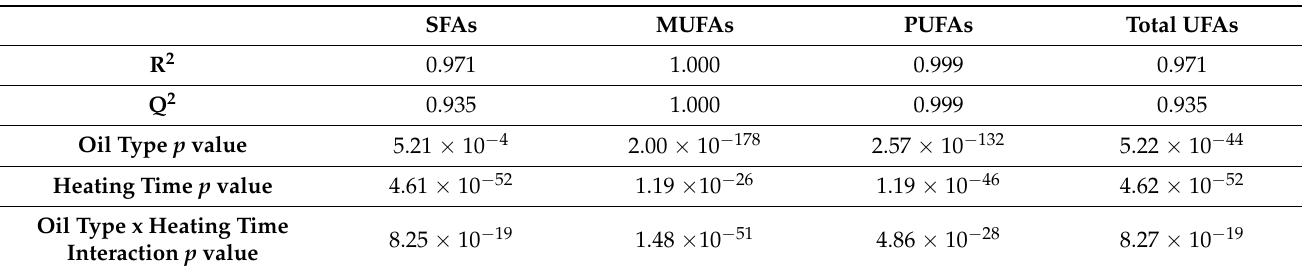
Table 2. Statistical significance of differences between the oil type and LSSFE sampling time-point main effect factors, and of the oil type x sampling time-point first-order interaction effect on the FA contents of culinary oils. In addition to the main factors, the latter interaction effect was very highly statistically significant for all FAs tested, and arises from differential responses of oil compositions to increasing LSSFE heating times (Figure S1). Additionally, R 2 and Q 2 values are provided for the mathematical model of Equation (1); R 2 corresponds to the linear predictive capacity of the Equation (1) model, whereas Q 2 represents the goodness-of-fit of a ‘test’ set of data points originally removed from the model which was then generated from the remaining ‘training’